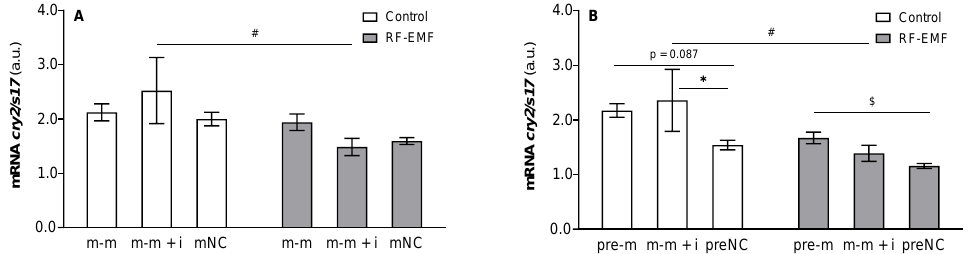
Figure 3. Effect of miR-34a administration on cry2 mRNA expression in DLD1 cells under control and RF-EMF conditions. Cells were transfected with ( A ) miR-34a-5p (m-m), ( B ) pre-miR-34a (pre-m), ( A , B ) mimic of mature miR-34a together with the miR-34a inhibitor (m-m + i) or corresponding negative control of mature and pre-miRNA (mNC and preNC, respectively). The data were relativised to the corresponding negative control measured under control conditions and presented as the mean ± SEM (n = 4). a.u.—arbitrary units. Two-way ANOVA, Tukey’s posthoc test, * p < 0.05, comparison between groups transfected with different oligos within the control or RF-EMF treatment; One-way ANOVA, Tukey’s post hoc test, $ p < 0.05, comparison within the control or RF-EMF treatment. Two-way ANOVA, Š í d á k’s multiple comparisons test, # p < 0.05 comparison between the control and RF-EMF groups. For a more detailed statistical analysis, please see the results.